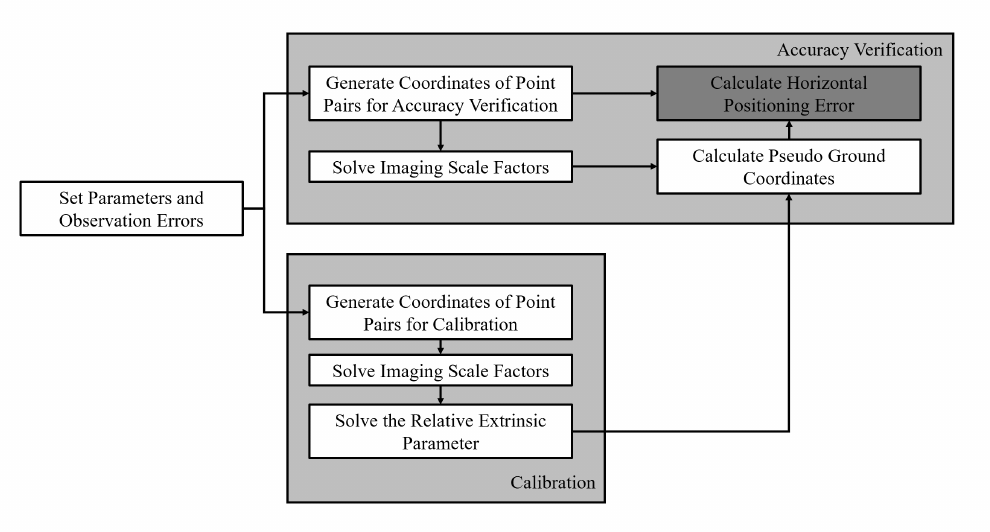
Figure 7. Flowchart of numerical